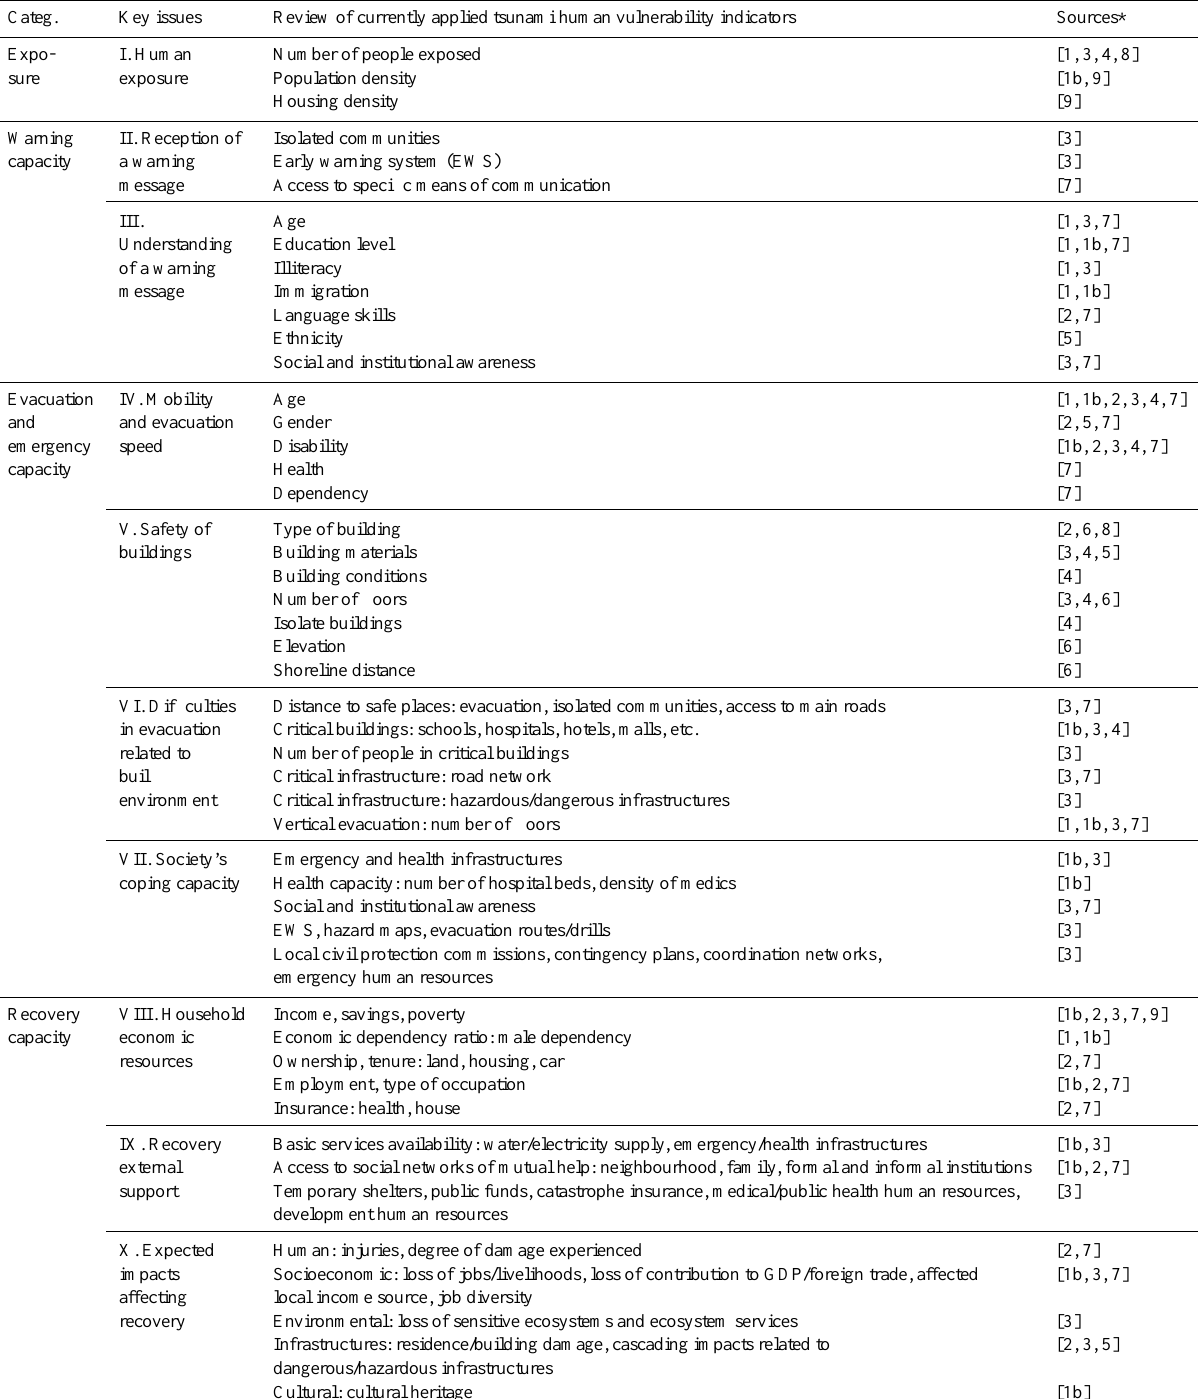
Table 1. Review of existing indicators and new framework for tsunami human vulnerability.